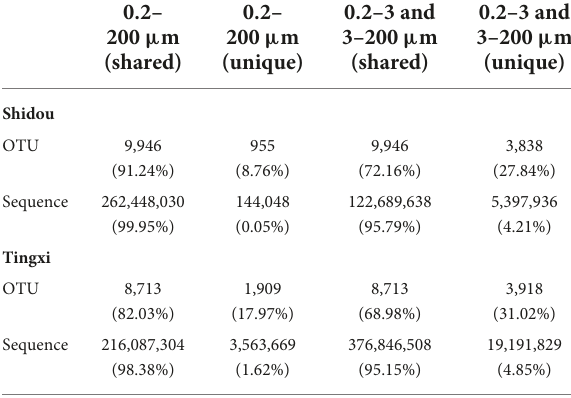
TABLE 2 The OTUs and sequences that are shared and unique between the 0.2–200 µ m ( n = 20) and 0.2–3 and 3–200 µ m ( n = 20) eukaryotic plankton communities from Shidou and Tingxi